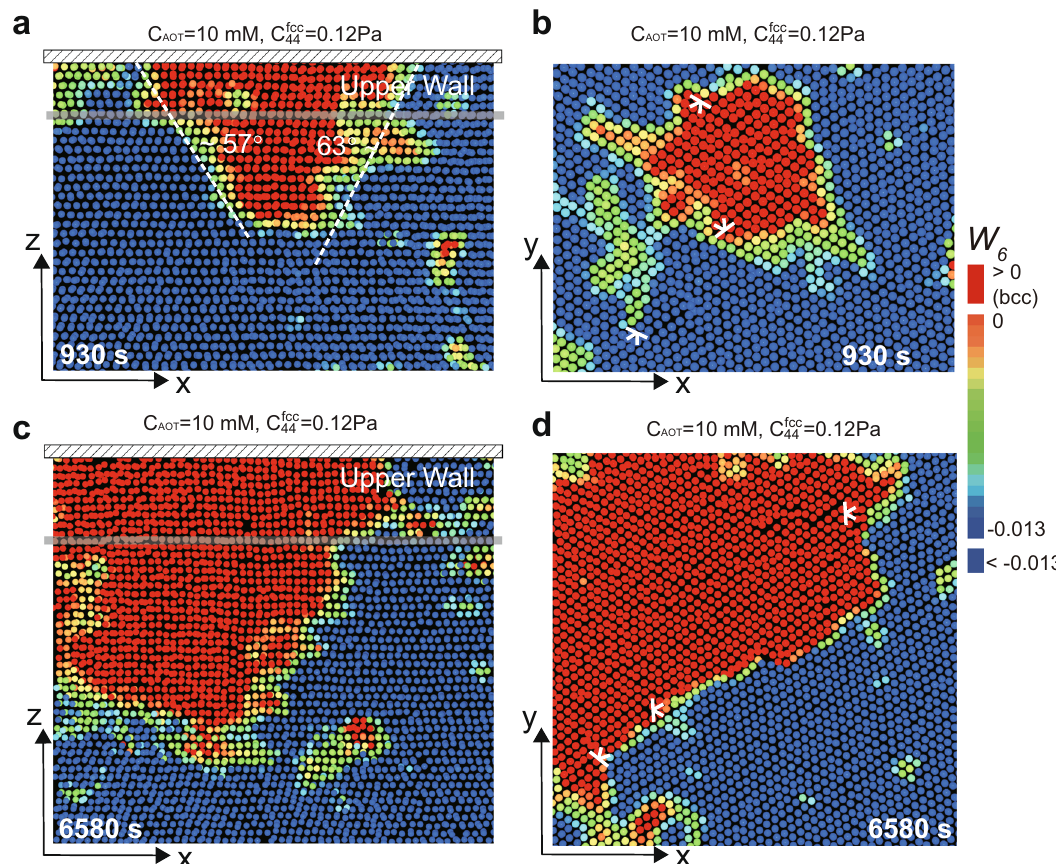
Fig. 9 Wall-assisted growth for pre-existing nuclei observed at the weak-driving force. a , b Small pre-existing nuclei formed on the x – z and x – y planes of a wall at t = 930 s. The smooth wall wets the bcc solid with an equilibrium contact angle of about 60°. c , d The wall-assisted growth corresponding to ( a and b ), respectively, due to the surface-energy reduction of the wall-induced